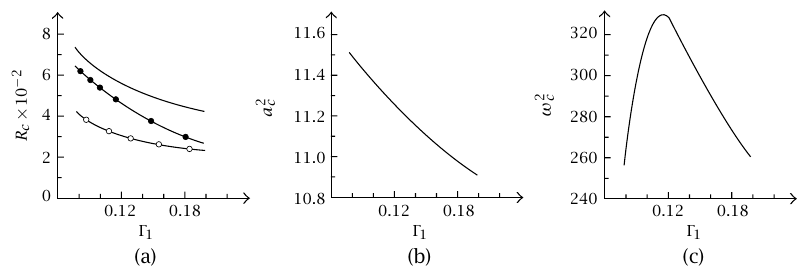
Figure 4.1 . Plot of R c , a 2 c , ω 2 c (respectively, (a), (b), and (c)) versus Γ 1 for different basic-state temperature profiles with respect to free-free velocity boundary combination. Parameter values: Q = 0 . 1 , Da = 5 . 0, and Λ = 0 . 9. (—) linear; ( • ) heating from below; ( ◦ ) step function.